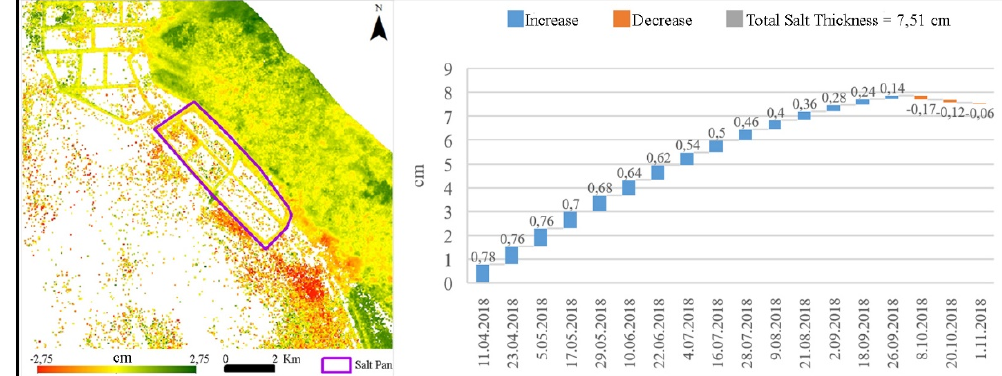
Figure 13. Salt movements obtained by SBAS results. The location of the salt pan is shown on the LOS directions SBAS map in the left image, while the change in the salt height in this salt pan is graphically displayed on the right (Calculations were made by converting to vertical units).